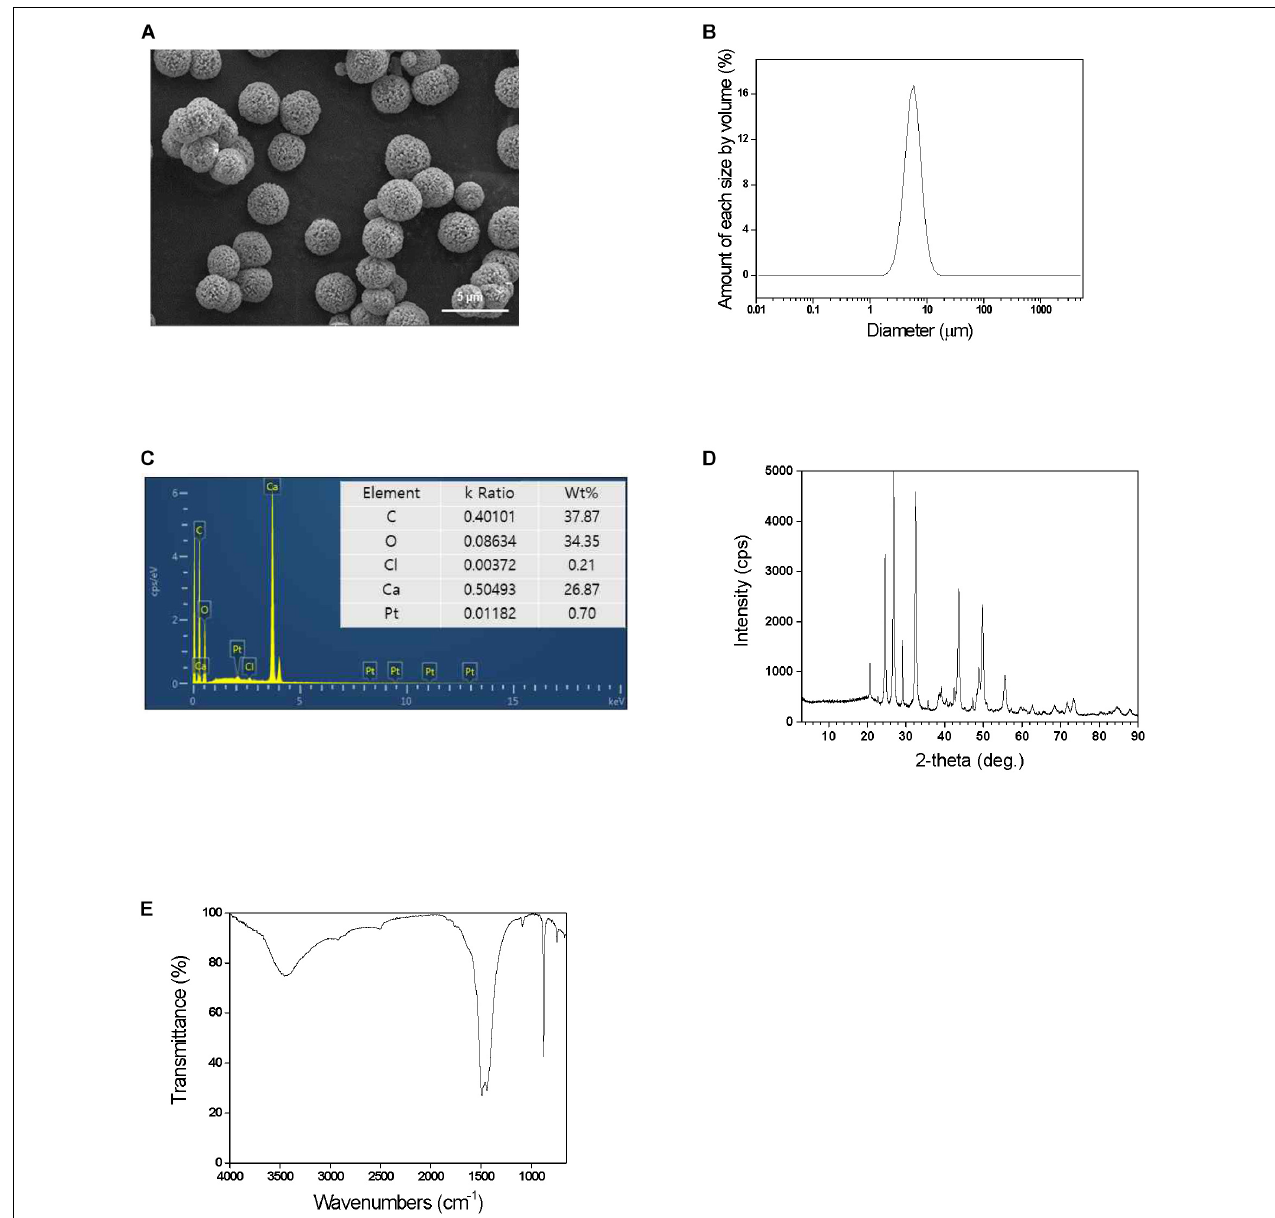
FIGURE 2 | (A) SEM images, (B) particle size distribution, (C) energy-dispersive X-ray spectroscopy (EDS), (D) XRD patterns, and (E) FT-IR spectrum of the prepared CaCO 3